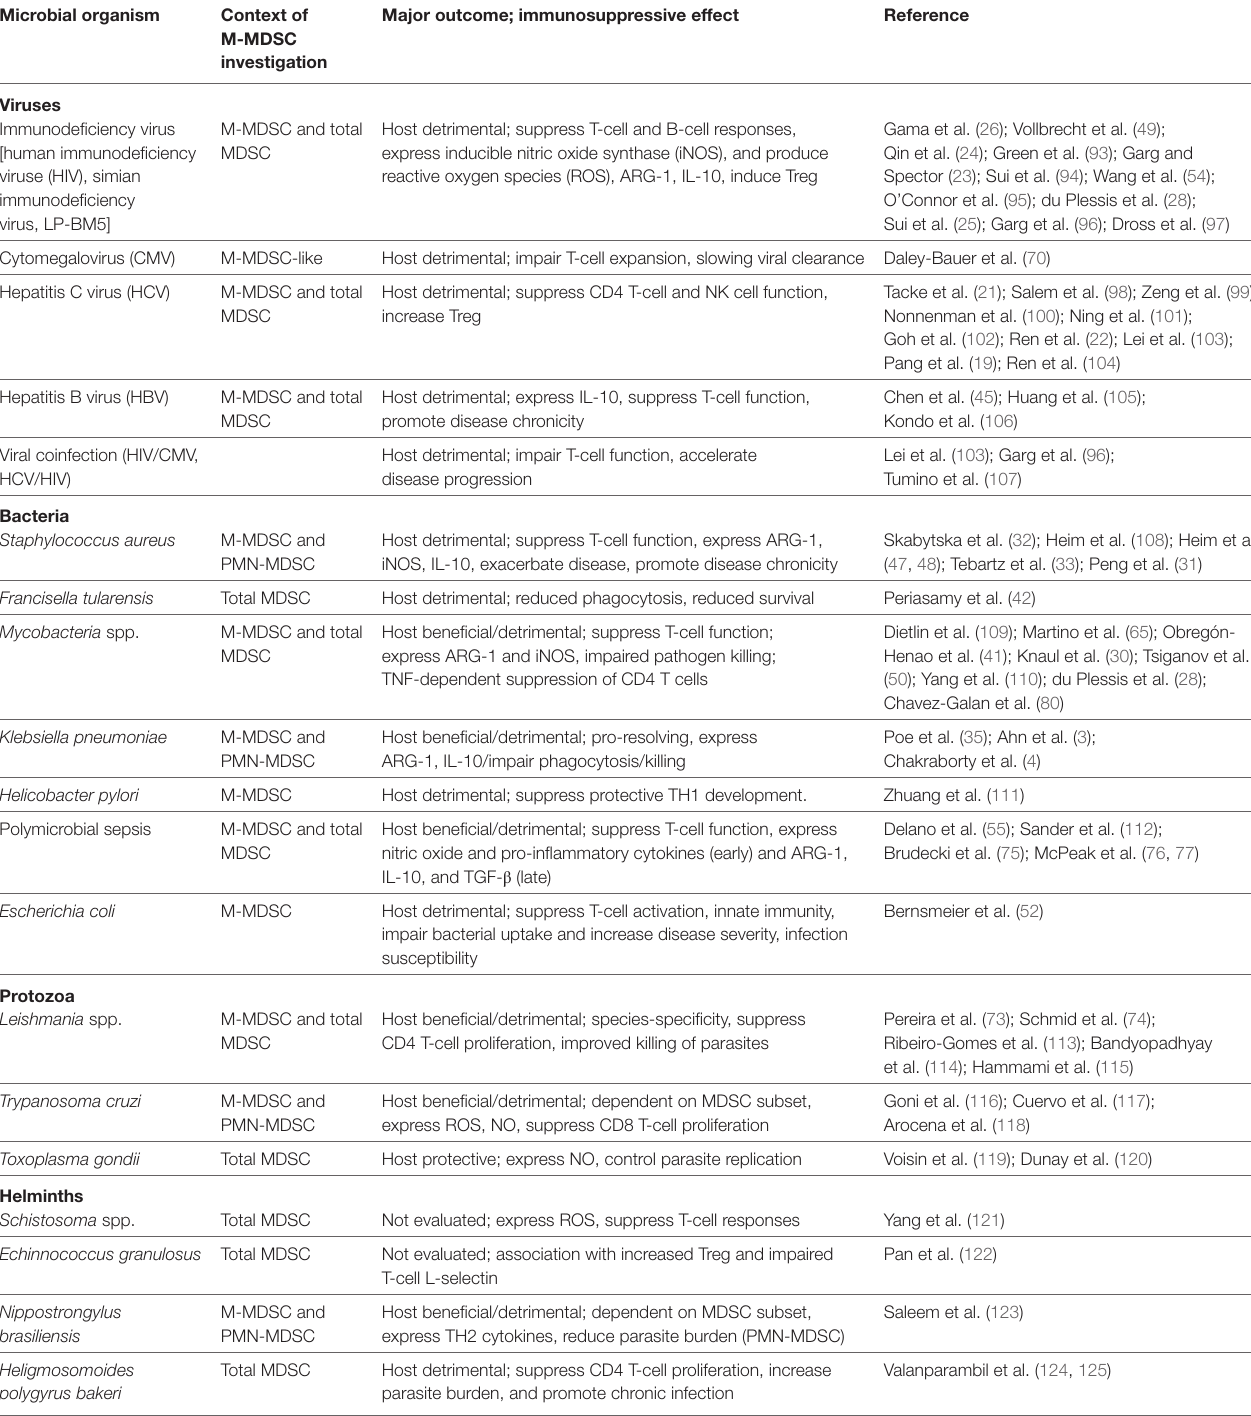
TABLe 1 | Impact of monocytic myeloid-derived suppressor cells (M-MDSC) on infectious disease outcome and their immunosuppressive effects. Microbial